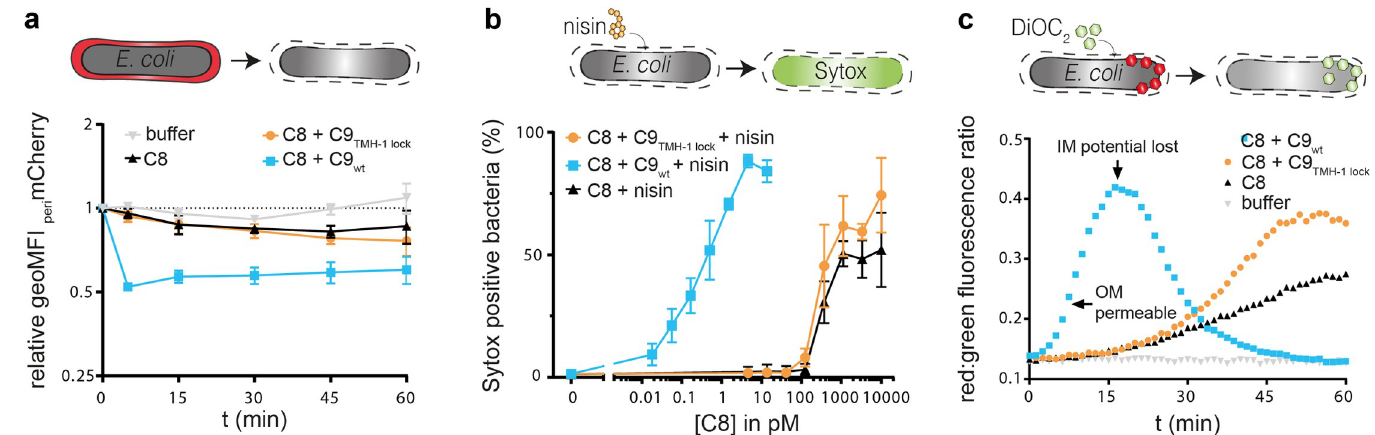
Fig 3. Polymerization of C9 increases OM damage by MAC pores. E . coli MG1655 (grey) was labelled with C5b-7 by incubating in 10% C8-depleted serum for 30 minutes. Bacteria were washed and next incubated with buffer, 10 nM C8 with 20 nM C9 wt or C9 TMH-1 lock to measure damage to the bacterial OM. a) periplasmic mCherry ( peri mCherry, red) leakage was measured at different time points by flow cytometry and represented as relative peri mCherry fluorescence compared to t = 0. b) C5b-7 labelled bacteria were incubated with a concentration range of C8 and 20 nM C9 wt or C9 TMH-1 lock supplemented with 3 μ g/ml nisin for 30 minutes. Nisin influx through OM was measured using Sytox to determine the percentage of cells that have a damaged bacterial IM as read-out for bacterial killing by flow cytometry after 30 minutes. c) DiOC 2 enters the periplasm when the OM is permeable and shifts from green to red fluorescence in cells with an intact inner membrane (IM) potential. DiOC 2 shifts back to green fluorescence when the IM potential is lost. Flow cytometry data are represented by geoMFI values of the bacterial population. Data represent mean +/- SD of three independent experiments (a and b). The multiwell plate-reader assay (c) is shown by one representative experiment that has been repeated at least three